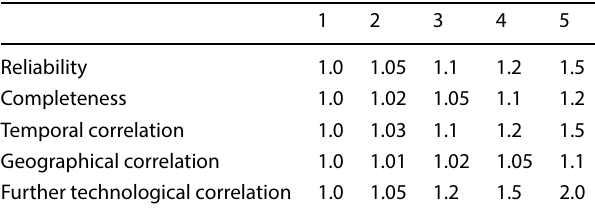
Table 8 Uncertainty factors for Ecoinvent data quality